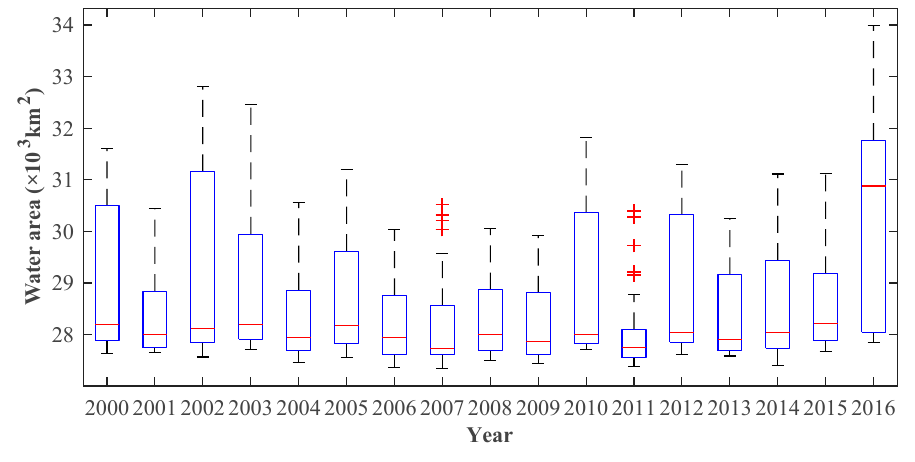
Figure 12. Change in surface water 2001–2016 in YRB. ‘+’ denotes the anomaly values for this year. Surface water area varies greatly in different months (Figure 13). The peak, median and valley values of the water area are obviously larger from May to September, and their largest values all occurred in July with water area of 33.99 × 10 3 , 30.21 × 10 3 and 28.72 × 10 3 km 2 , respectively. April and October are special. Their maximum water area is large basically as same as May–September, and the minimum water area is small the same as other months.